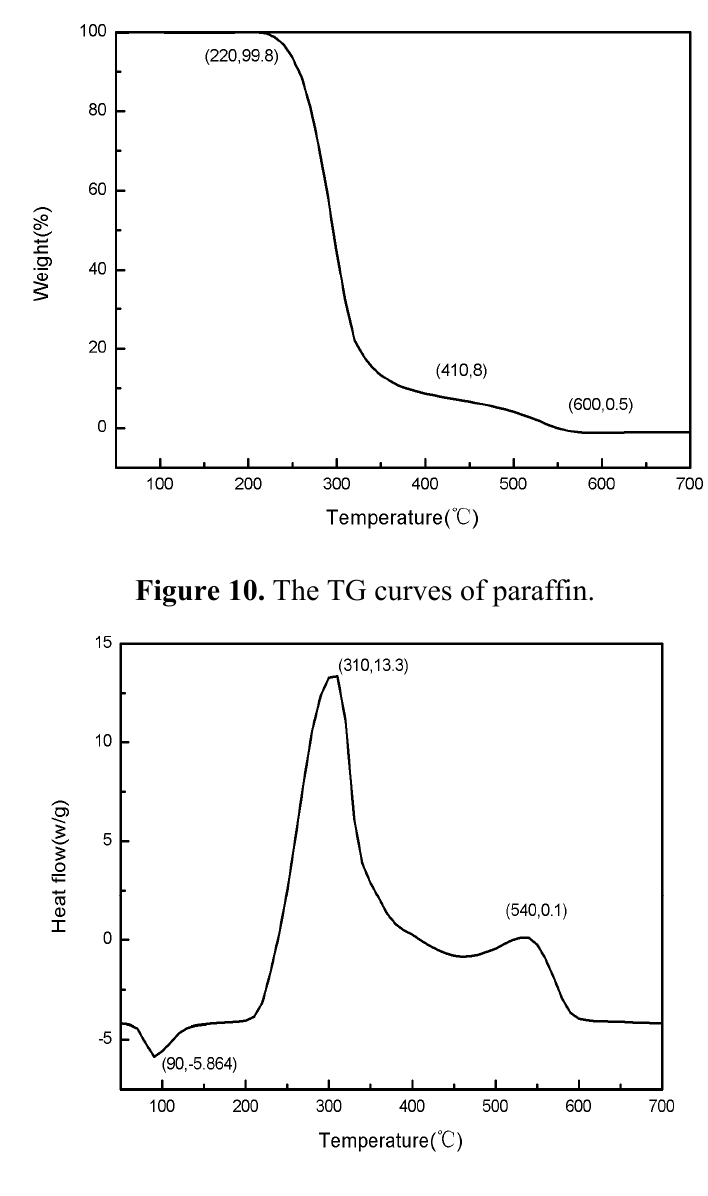
Figure 11. The DSC curves of